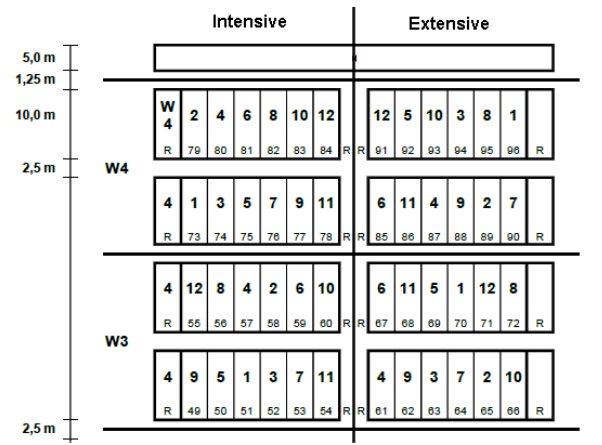
Figure 1. Experimental field set up in Klein